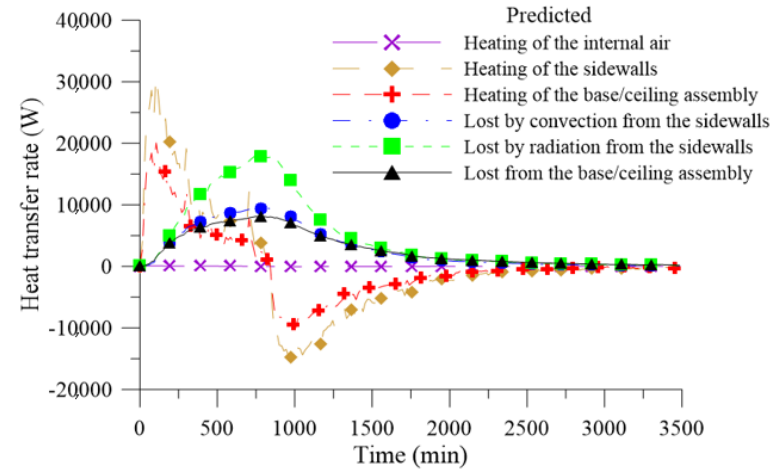
Figure 13. Heat transfer rates in the kiln without thermal insulation.